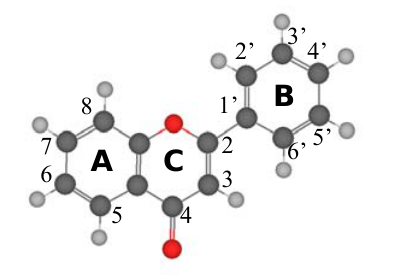
Figure 1. A molecular diagram of Flavone, showing atom numbering and ring names. Structure optimized at B3LYP ⁄ 6-311++G** theoretical